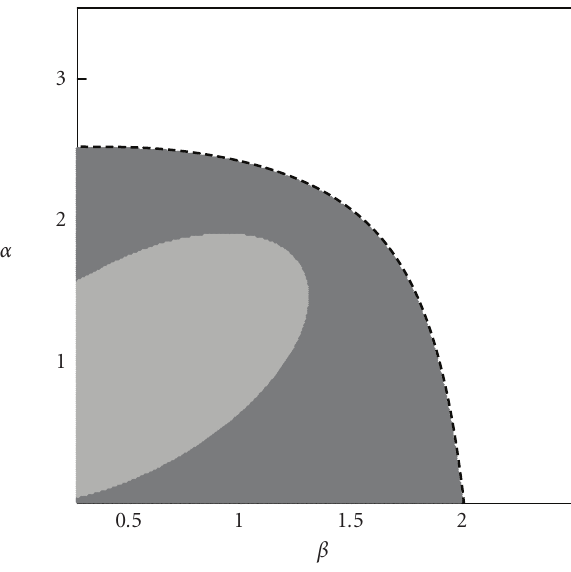
Figure 7.1. Region of stability of the equilibrium of model 2 in the ( β , α ) parameter